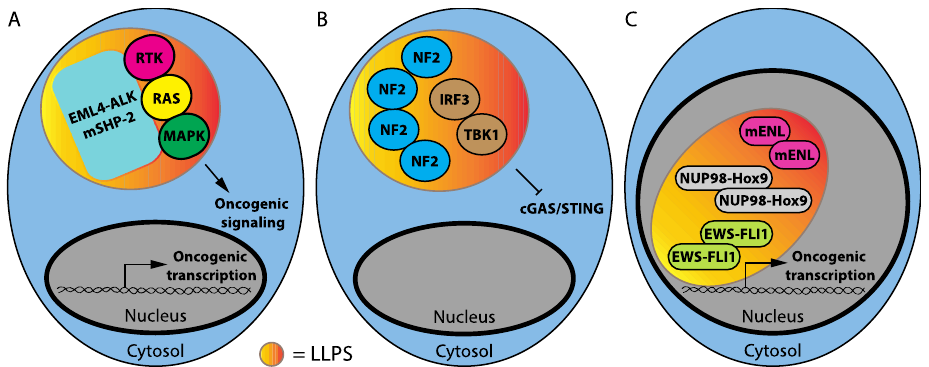
Figure 1. Biological condensates of mutant oncoproteins. ( A ) SHP-2 and EML4-ALK roles in LLPS formation and RAS-MAP kinase signaling. ( B ) NF2 roles in LLPS formation, sequestration of IRF3/TBK1 and disruption of the cGAS-Sting pathway. ( C ) LLPS of transcription complexes as driver of transcription programs.